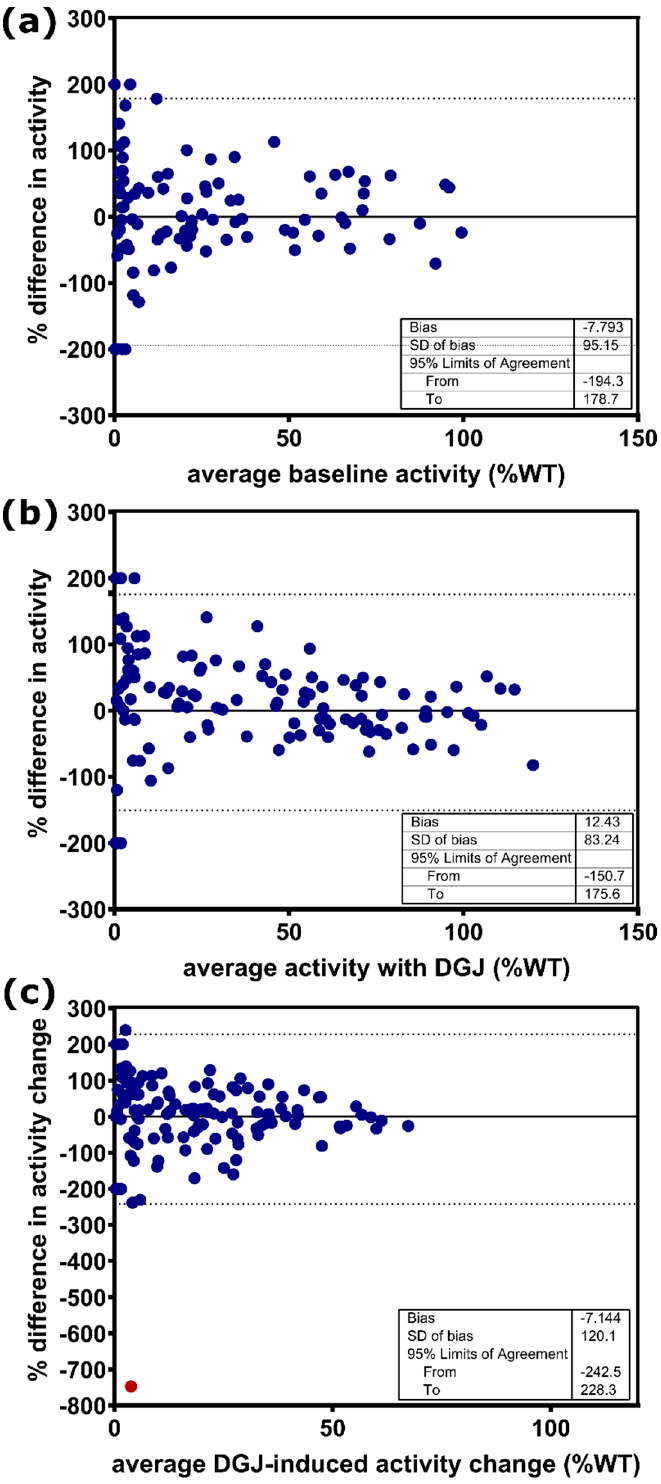
Figure 2. Bland–Altman analysis of α -Gal A activity for GLA variants expressed as percentage difference in activity (%WT) between the in-house assay and the GLP-validated assay. ( a ) Baseline α -Gal A activity without the addition of DGJ. ( b ) α -Gal A activity with DGJ. ( c ) DGJ-induced α -Gal A activity change. The dotted line indicates the 95% limit of agreement. SD: standard deviation.